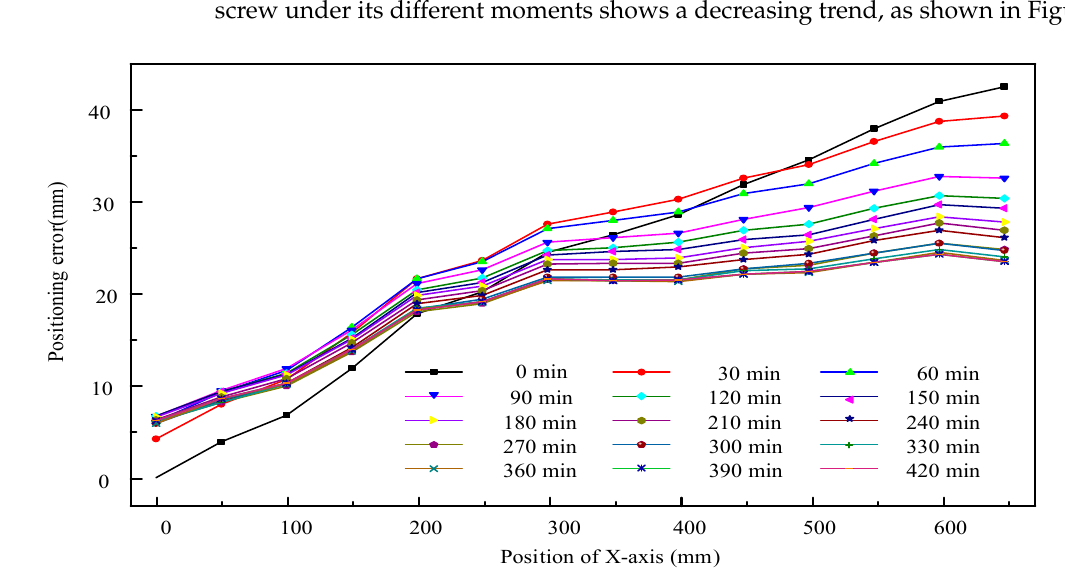
Figure 10. Positioning errors at different positions of the X-axis. Three linear regressions fit the temperature change matrix in Figure 8 to obtain the slope of its corresponding position at different moments. It can be observed from Figure 11 that the change in temperature slope and the change in displacement of the X-axis have the same directional consistency, both showing characteristics of the concave function. The trend of temperature change decreases, and the displacement change gradually stabilizes with increasing time. 0 Running time (min) Positioning error displacement slope Figure 11. Temperature slope change versus displacement slope change graph. Therefore, the slope of the slope of the primary fitting matrix of the positioning error on the X-axis can be considered for the initial screening of the gray correlation with the variation in a temperature rise of the ten temperature sensors to establish the degree matrix of the gray correlation. Using Dunn’s correlation degree, i.e., 𝛾(𝑦, 𝑥 (cid:3036) ) = 1 𝑛 (cid:3533) 𝑟(𝑦 (cid:3038) , 𝑥 (cid:3036)(cid:3038) ) (cid:3041) (cid:3036)(cid:2880)(cid:2869) (4) In Equation (4), 𝑦 represents the slope of the geometric error displacement change, 𝑥 (cid:3036) represents the 𝑖- th temperature measurement point, 𝑦 (cid:3038) represents the slope of geo- metric error displacement change, 𝑥 (cid:3036)(cid:3038) represents the 𝑘- th observation of the changing trend of the 𝑖- th temperature measurement point. 𝛾(𝑦, 𝑥 𝑖 ) is the gray correlation between the slope of the geometric error displacement change and the changing trend of the 𝑖- th